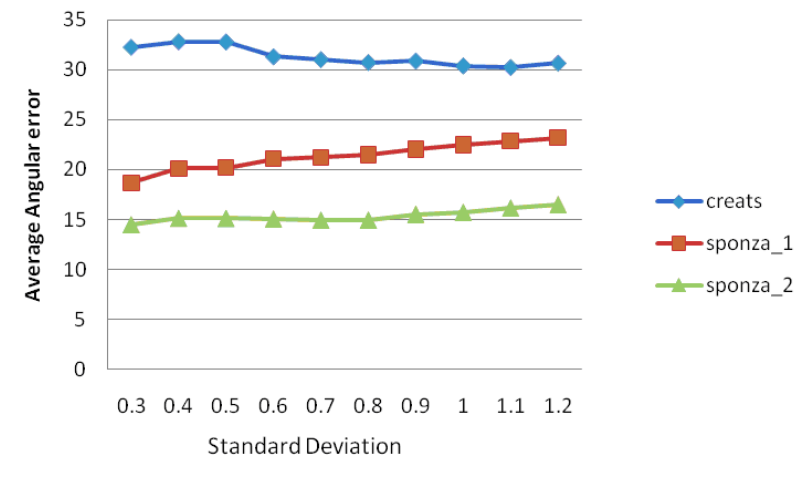
Figure 10. Average angular error measures of iterative pyramidal L-K optical flow by using Gaussian Filtering on all resized input